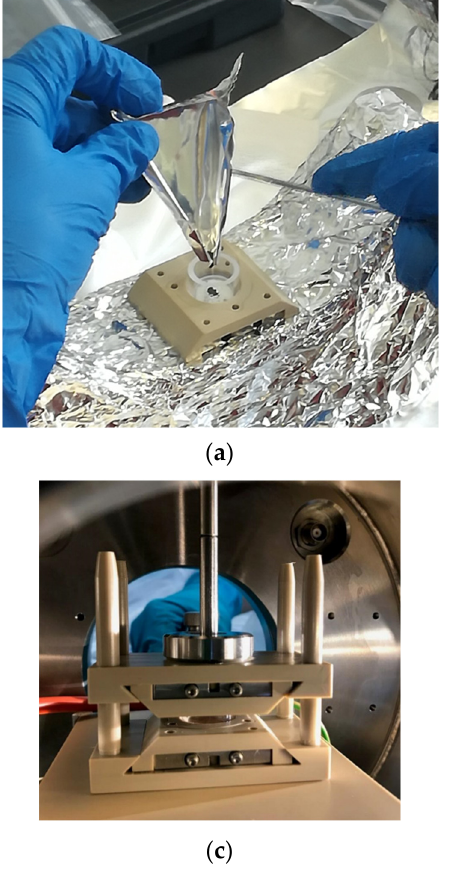
Figure 7. First version of the sample holder according to the design by I. Sugai [2]: ( a ) picture of assembled sample-holder; ( b ) assembly step by two people.